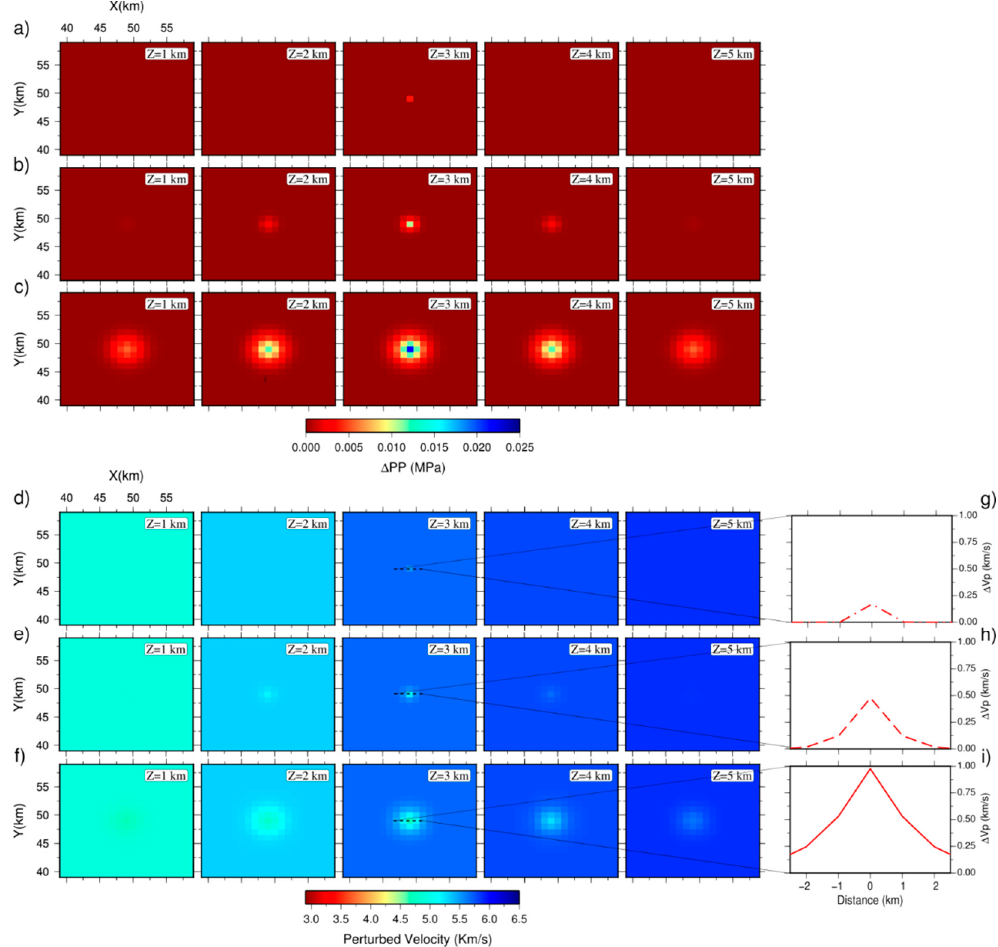
Figure 4. Diffusion of the pore pressure perturbation ( a – c ) and the consequent perturbed velocity model ( d – f ) around the injection well (placed in the center), with a rate of 500 m 3 / day and a D of 1 m 2 / s, after 1 day ( a – d ), 1 week ( b – e ), and 1 month ( c – f ) from the continuous injection. Temporal evolution of the 1D velocity perturbation, along the EW direction and cantered on the injection point, after 1 day ( g ), 1 week ( h ), and 1 month ( i ) from the continuous injection.